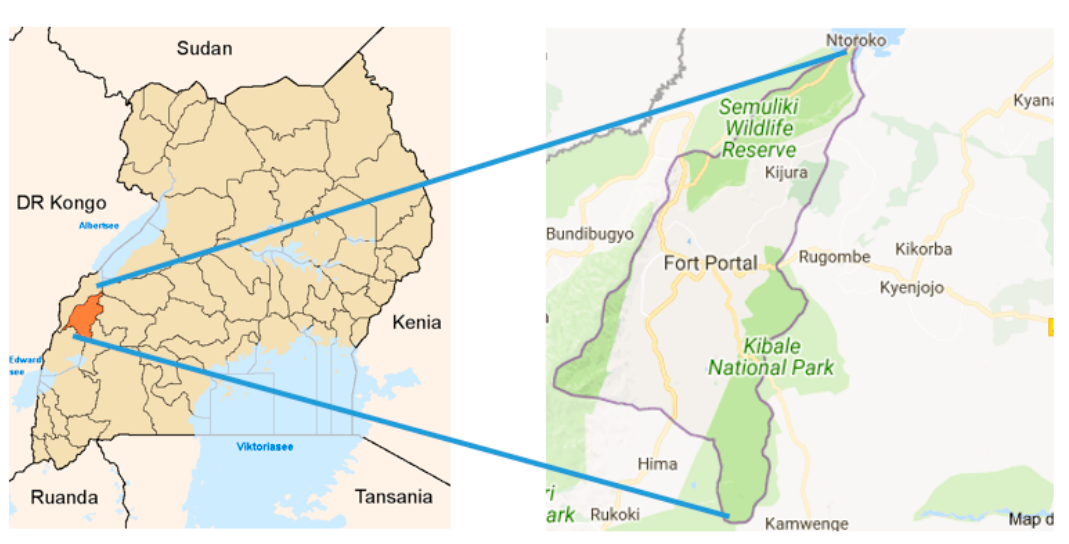
Figure 1. Location of Kabarole district on the Ugandan map (Source: Google maps).